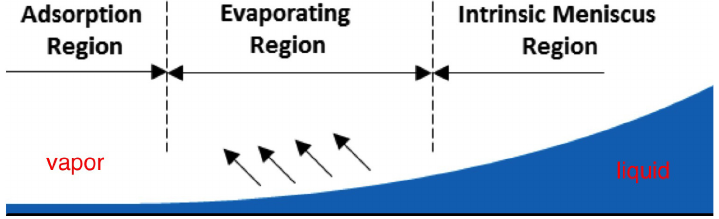
Figure 1. Schematic of evaporating thin